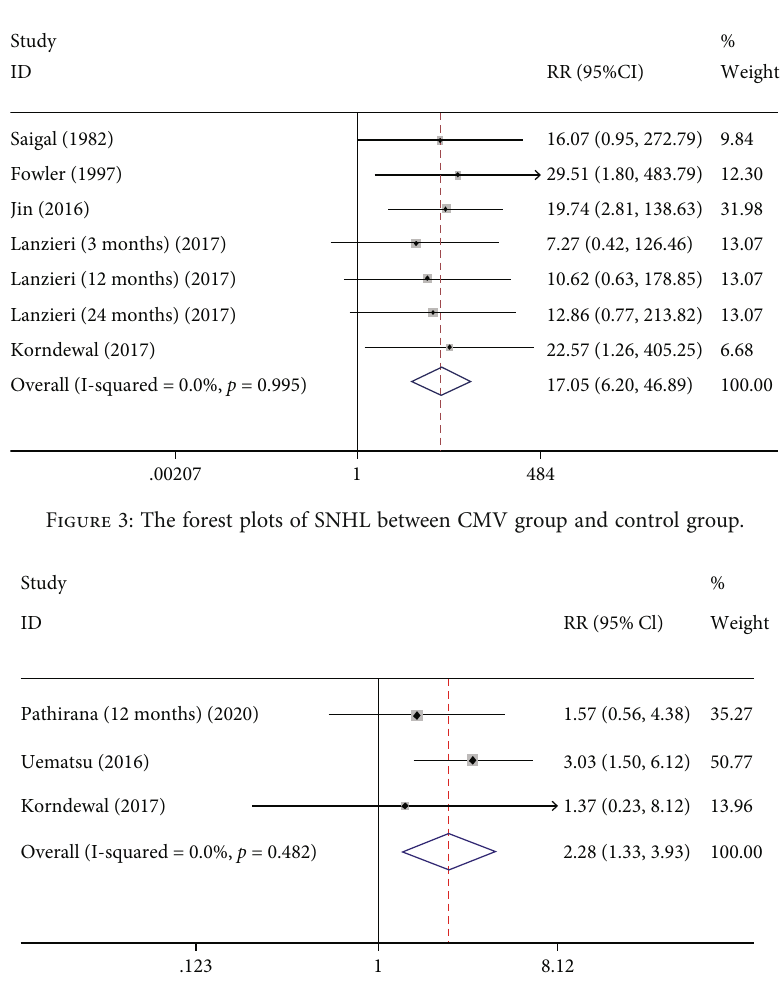
Figure 4: The forest plots of microcephaly between CMV group and control group.